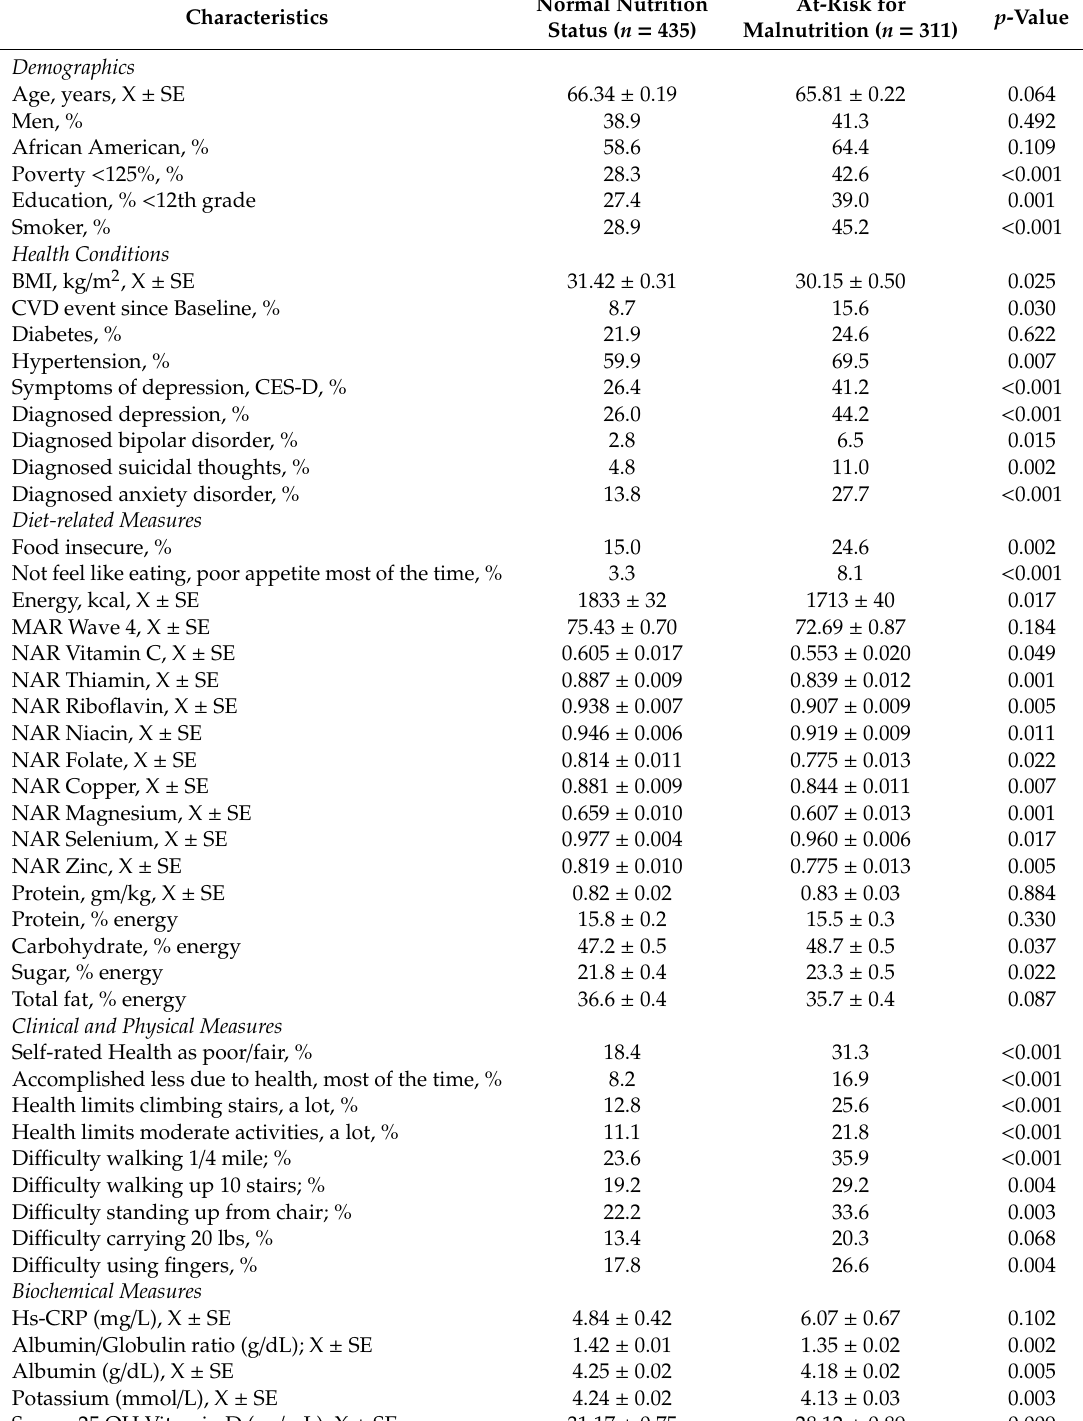
Table 2. Demographics and diet- and health-related characteristics of HANDLS study participants aged ≥ 60 years at Wave 4 categorized by risk for malnutrition, screened by Mini Nutritional